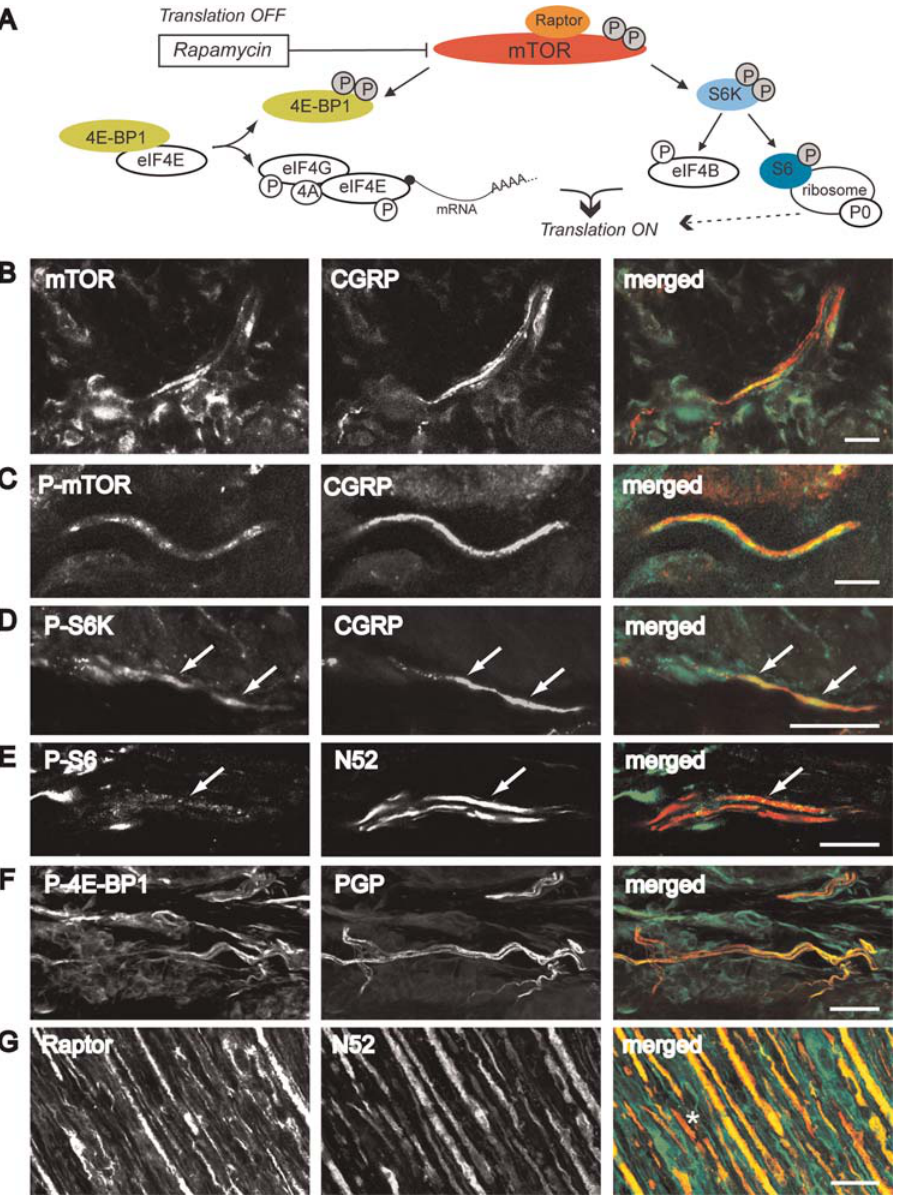
Figure 2. Translation-related factors are localized in peripheral nerve fibers and terminals in the skin. A , Diagram of mTOR signalling pathways and translational modulation. P, phosphorylation [24,33,34,80]. B-F , Confocal images of 40 m M thick sections cut perpendicular to the plantar skin surface of the rat hindpaw. B-D , Colocalization of mTOR (B) phospho-mTOR (C) or phospho-S6K (D) and CGRP positive fibers in the dermal glabrous skin. E , Colocalization of phospho-S6 and N52 in the dermis of glabrous skin. F , Colocalization of phospho-4E-BP1/2 and PGP in the dermal glabrous skin. G , Colocalization of raptor and N52 in the sciatic nerve. In B-G , the single staining for each antibody and the merged image are shown from left to right. Double staining appears in yellow. White arrows indicate double-labelled fibers. Asterisk (*) indicates N52- positive fibers not double labelled. B , E single focal planes; C , 8 z-focal planes (2.3 m m); D , merge of 14 z-focal planes (8.5 m m depth); F , merge of 59 z-focal planes (17 m m depth); G , 28 z-focal planes (11 m m). Scale bars, B-E, G: 25 m m; F: 10 m